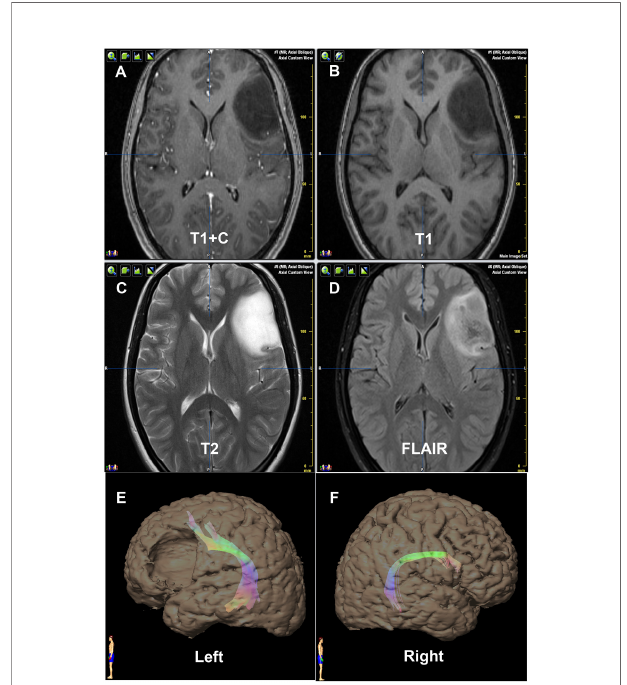
FIGURE 2 | Contrast of bilateral AF by DTT of Patient No. 9. Panels (A – D) are preoperative MRI T1+C, T1, T2, and FLAIR, respectively, on one same transverse slice of Patient No. 9, who was diagnosed as primary astrocytoma in insular and temporal lobe. Panels (E, F) show that the relative more fi ber number and volume of AF are on the left hemisphere, which are in concordance with the language dominant side of Wada